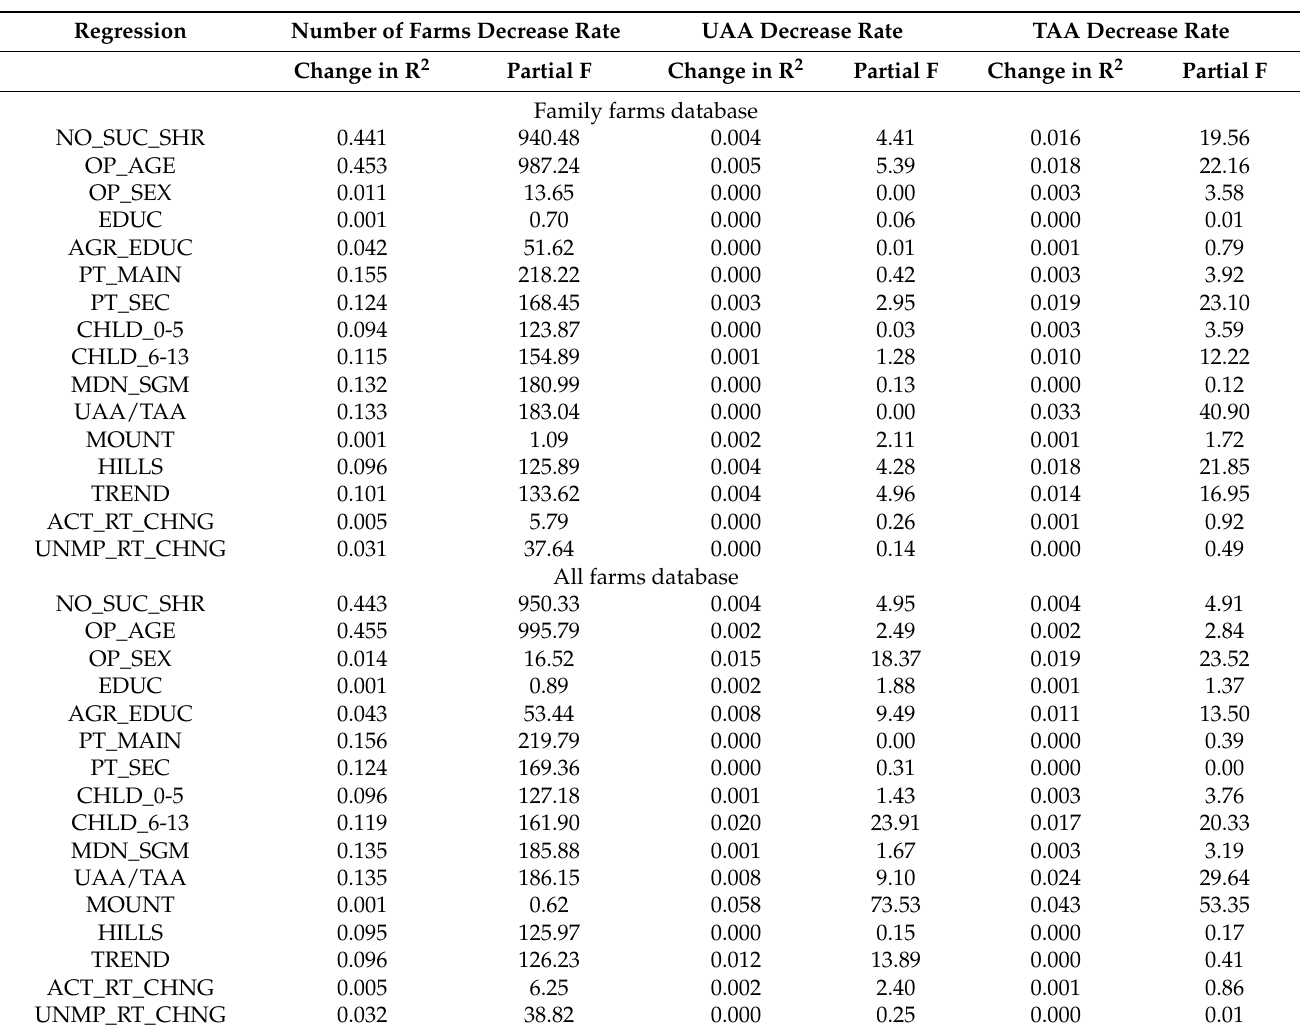
Table A9. Contribution of individual variables to the